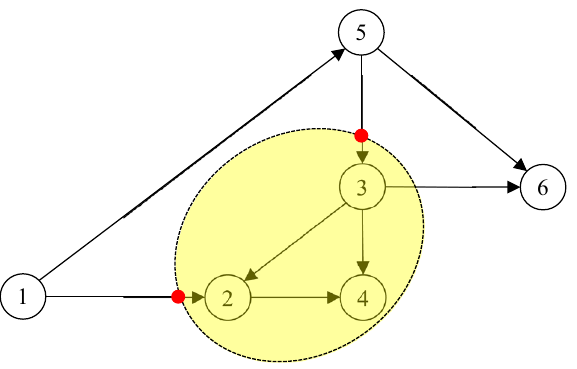
Fig. 2 Small network and